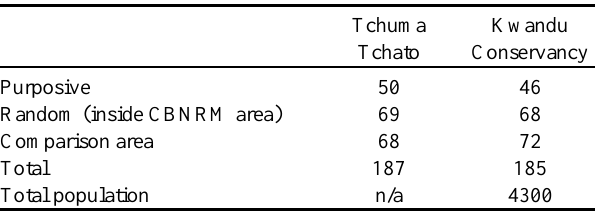
Table 2 . Household survey sample size by category. CBNRM = community based natural resource